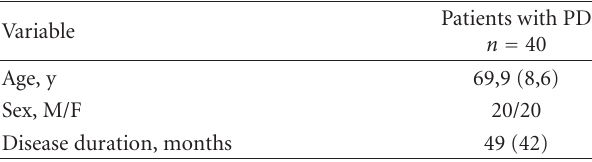
Table 1: Characteristics of the population studied. Table 2: Results of 24h ambulatory blood pressure